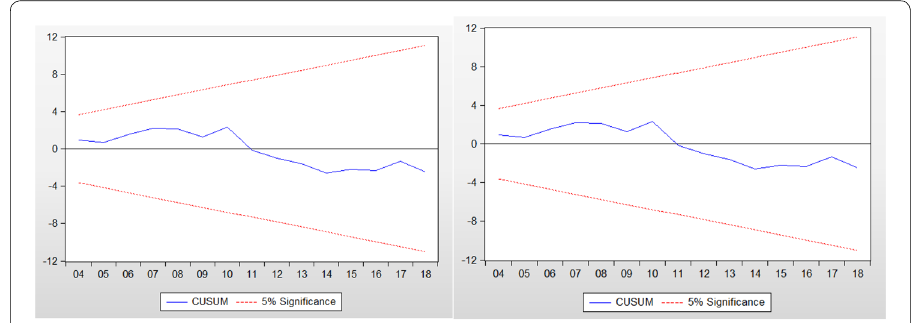
Fig. 1 Plot of cumulative sum of recursive